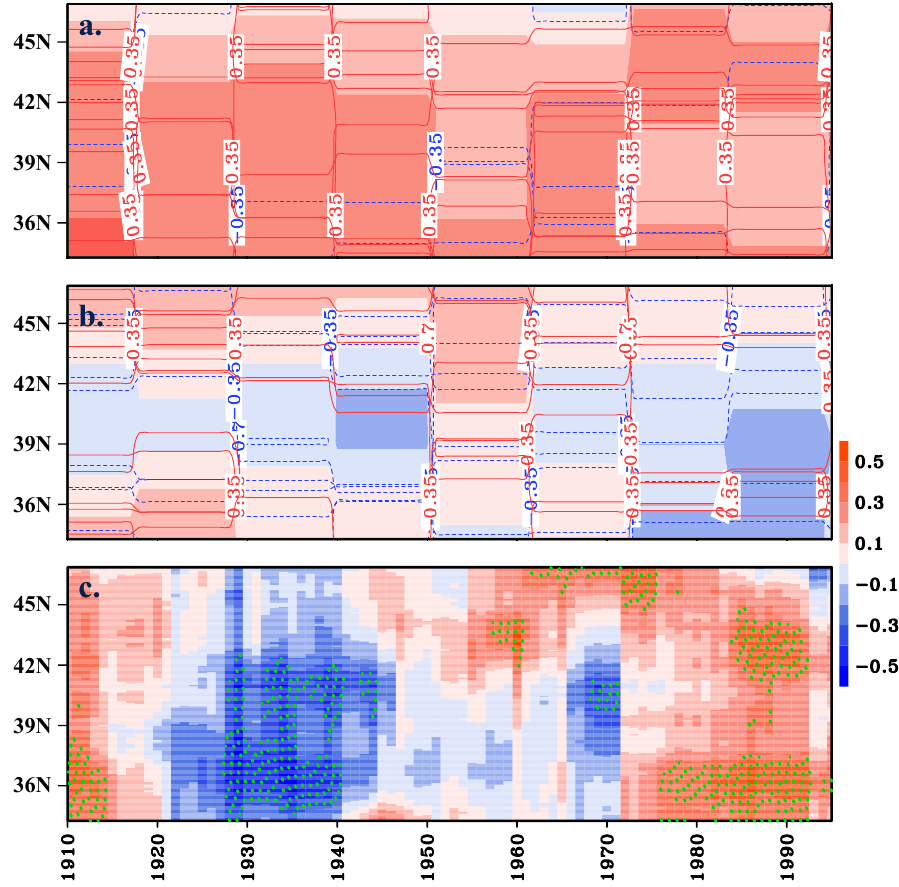
Figure 5. 20-years sliding correlation between the December Nino 3.4 index and precipitation averaged longitudinally over 95 ◦ W–85 ◦ W, as depicted by 17 CMIP5 models in two scenarios—( a ) GHG run and ( b ) Natural run. Shading represents the ensemble mean. Years on the x axis represent the central years of the sliding window. The ensemble spread is in contours and only statistically significant contours at the 90% confidence level are drawn. Figure 5c is a repeat of Figure 2c with a comparable timespan to the model runs.